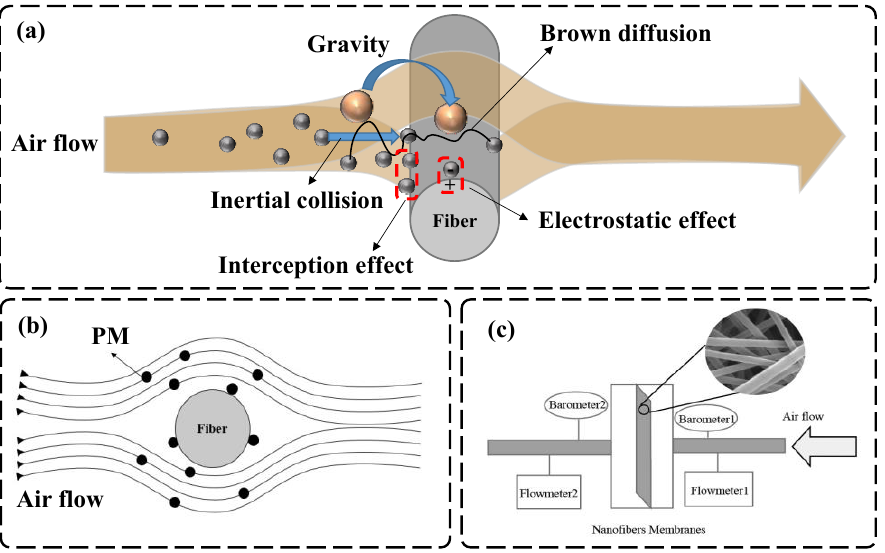
Figure 6. Five mechanisms of fiber filtration: ( a ) filtration mechanisms in the air filtration process; ( b ) aerosol particle motion flowlines; ( c ) filtration test diagram.